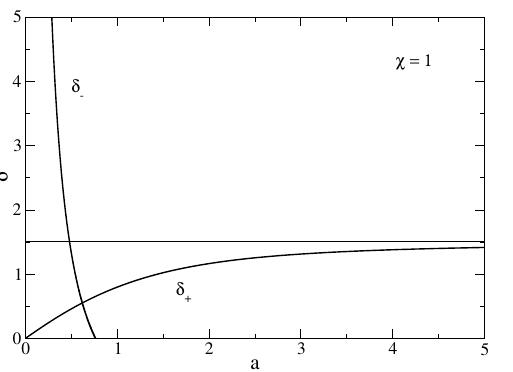
Figure 1. Growing and decaying modes of a dissipative noninteracting BEC in the TF limit (¯ h = c 2 s = 0) in an expanding background. We have taken χ = 1 for